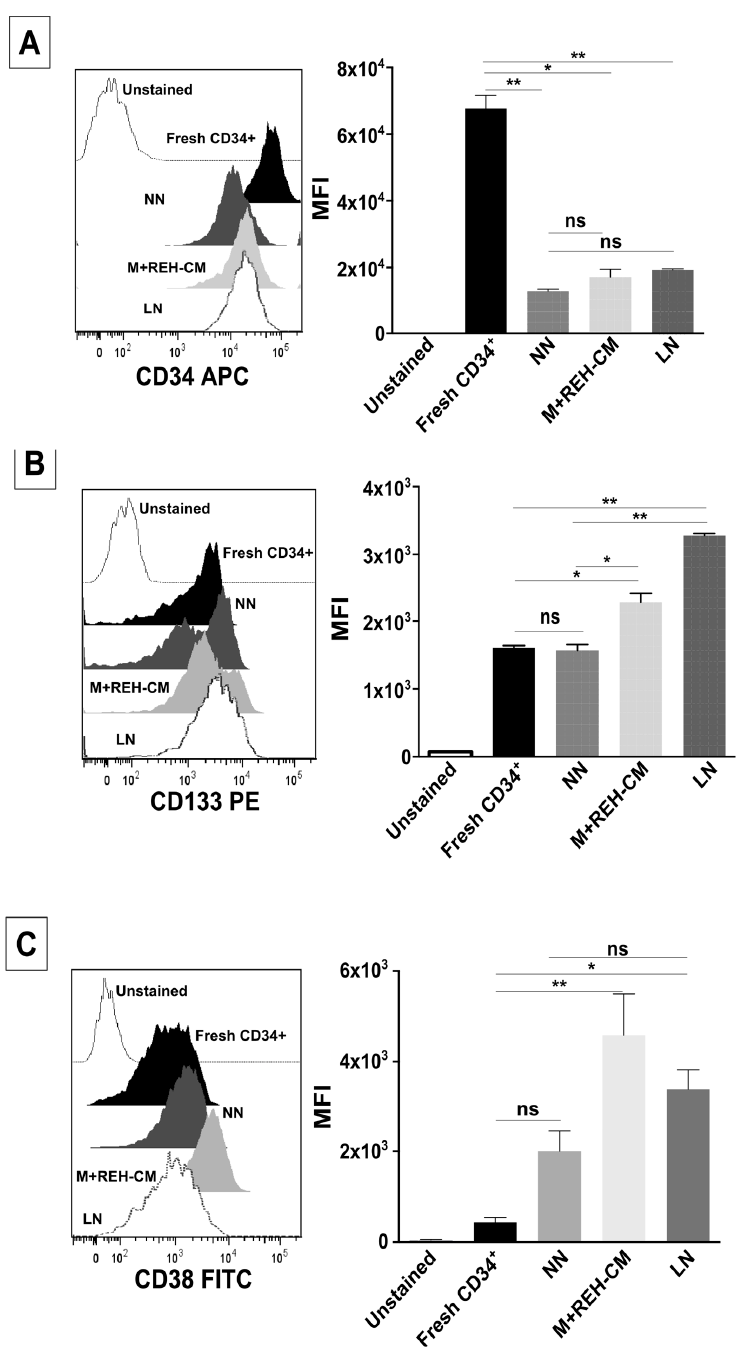
Figure 4. Figure 4. Changes in stem cell and differentiation markers of CD34 + cells in the LN . Flow cytometry analysis of ( A ) CD34, ( B ) CD133, ( C ) CD38, and ( D ) CD117 (c-Kit) expression in freshly-isolated, NN, M + REH-CM, and LN CD34 + cells. Results are expressed as the median fluorescence intensity (MFI) obtained from two independent experiments done in triplicates ( n = 6) (ns: non-significant, * p < 0.05, ** p < 0.01). 2.4. Multipotency Determination in the LN